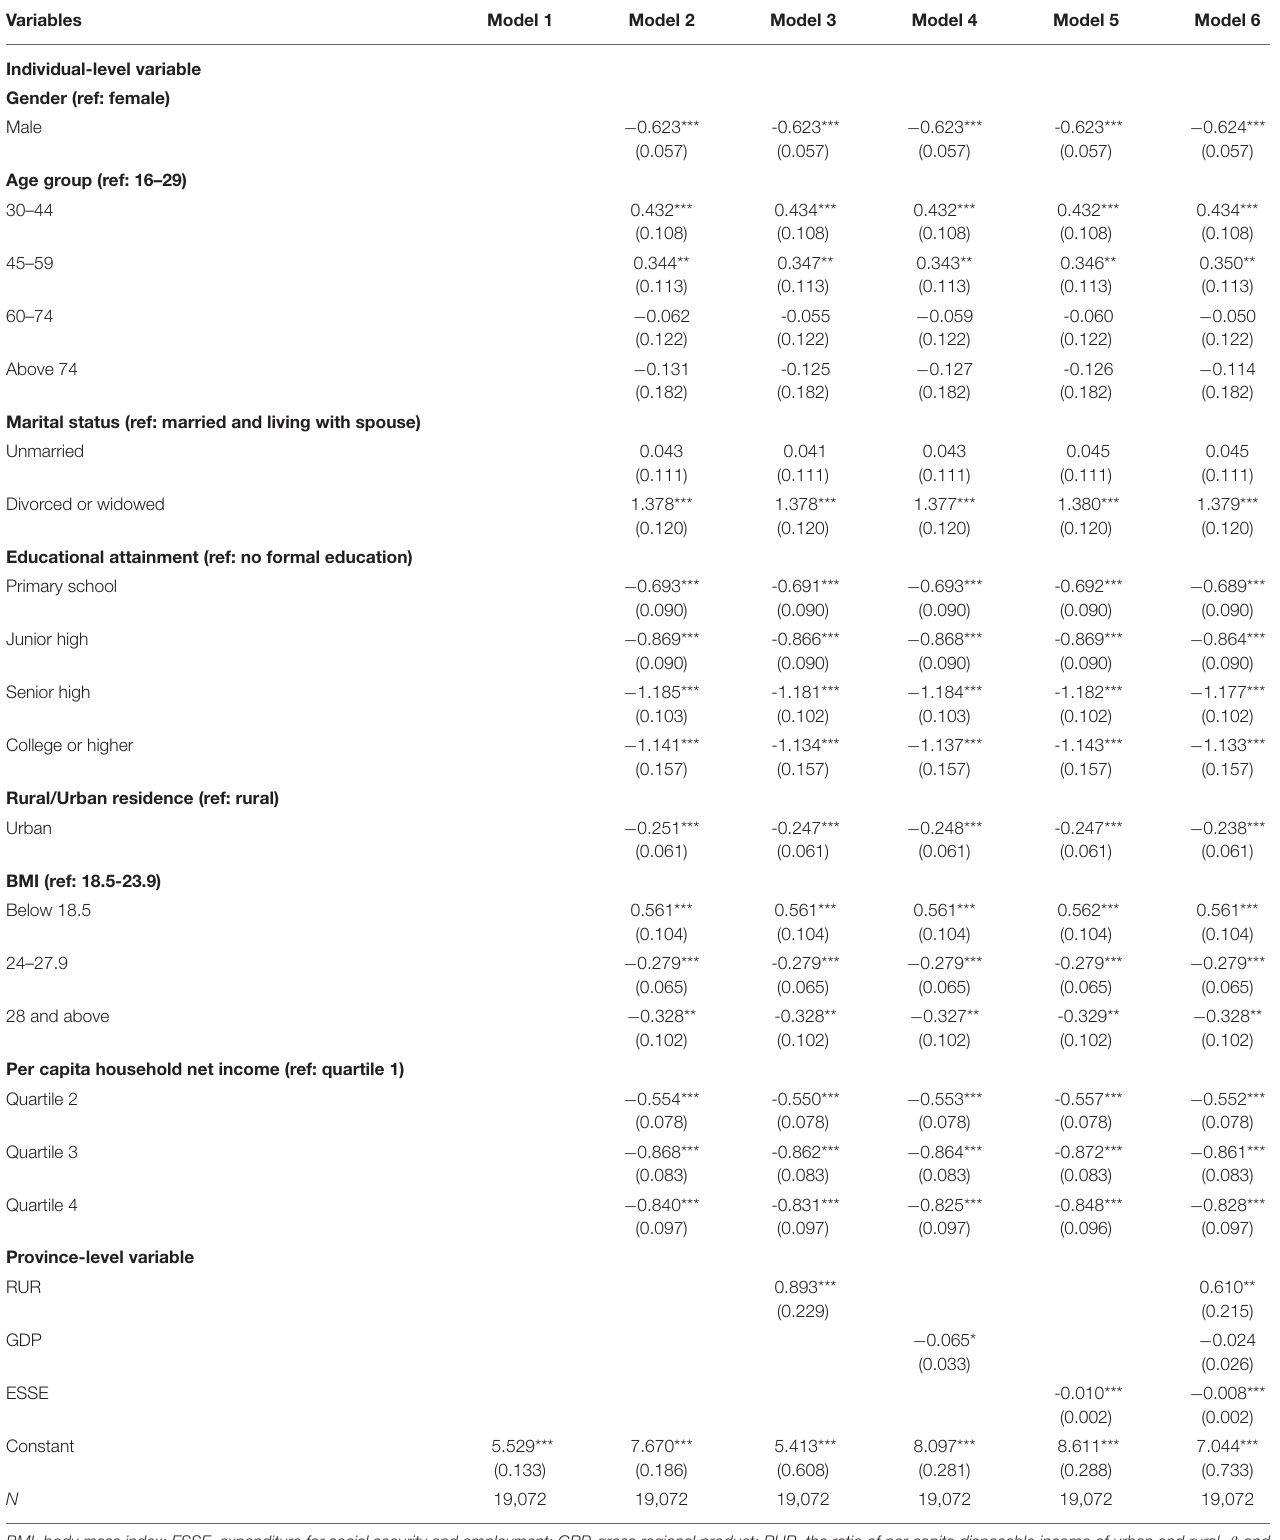
TABLE 2 | Results for the two-level multilevel linear regression